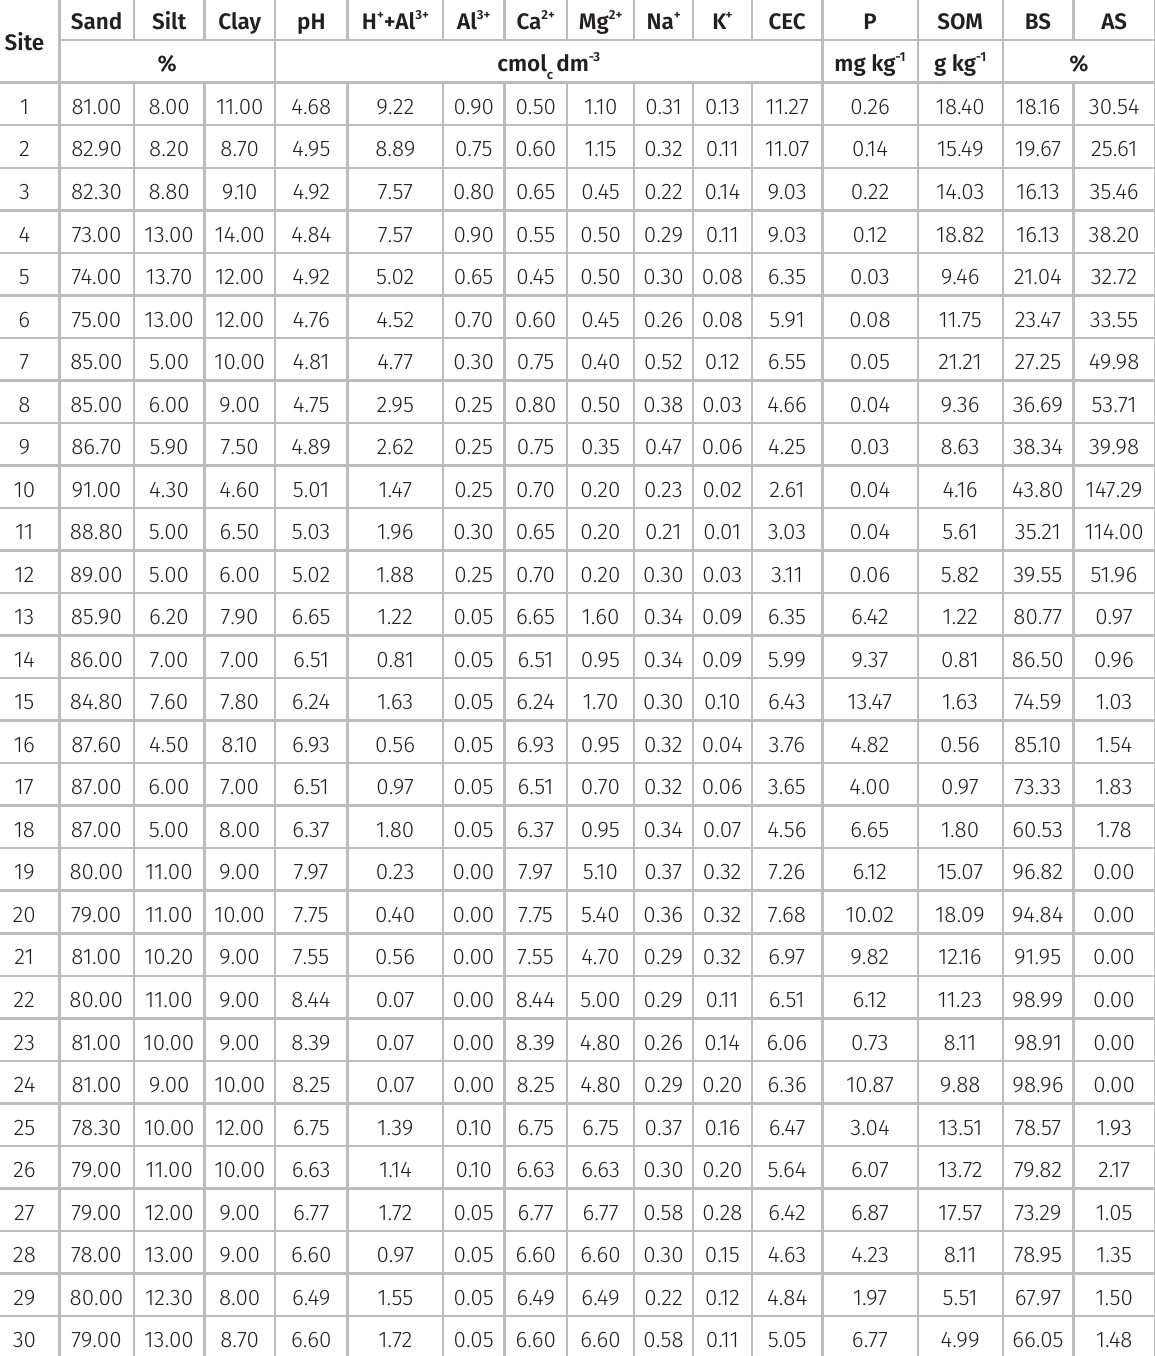
Table I. Physical and chemical attributes of soils under different land uses in the riparian zone around Extremoz Lake, northern Brazil. Potential acidity (H + + Al 3+ ); exchangeable aluminum (Al +3 ); available phosphorus (P); exchangeable sodium and potassium (K + and Na + ); exchangeable calcium and magnesium (Ca 2+ and Mg 2+ ); soil organic matter (SOM); total cation exchange capacity (CEC); base saturation (BS); aluminum saturation (AS). Natural vegetation (locations 1-6), pasture use (locations 7-12), agricultural use ( Saccharum officinarum ; locations 13-18), urban use (locations 19-24), and industrial use (locations